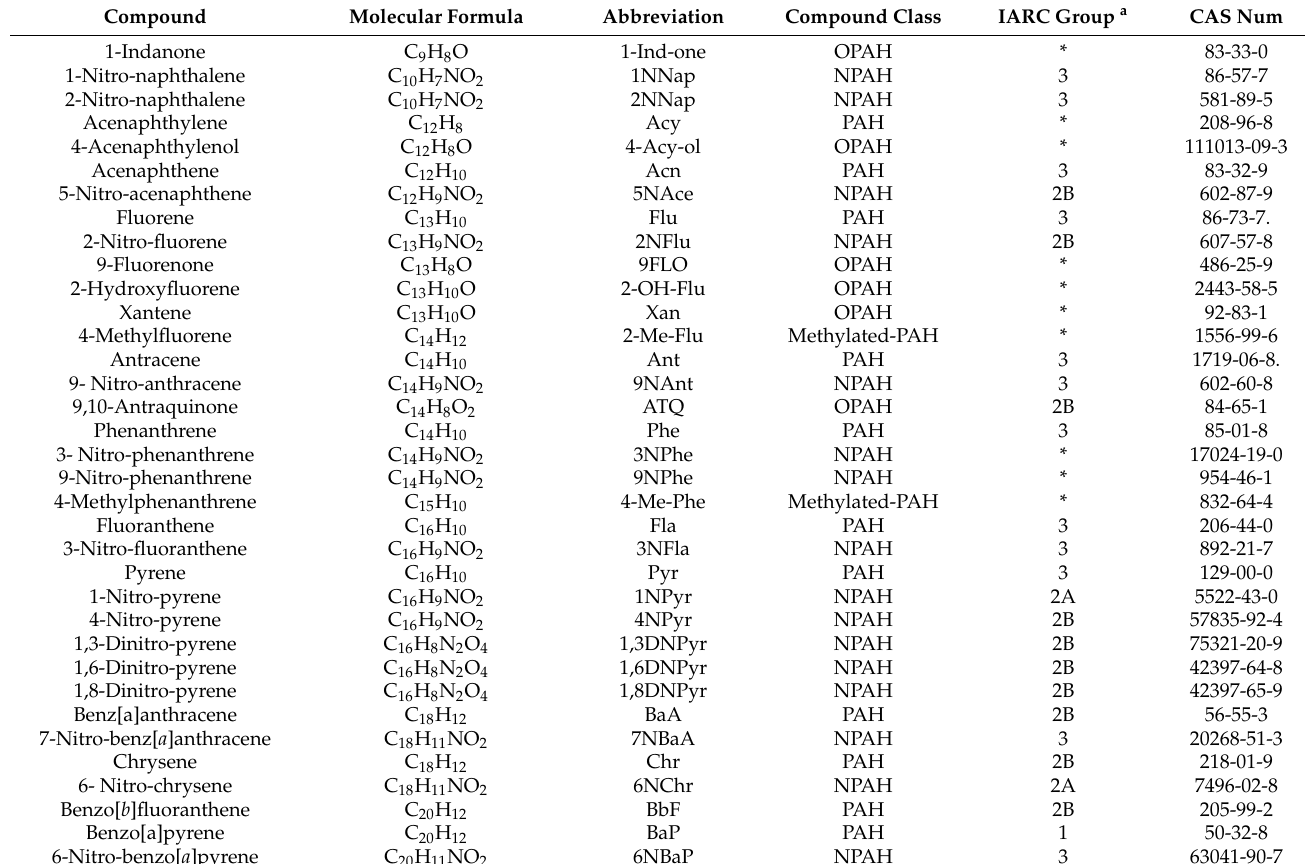
Table 1. List of reported polycyclic aromatic hydrocarbons (PAHs), nitro-PAHs (NPAH) and oxy- PAHs (OPAH) with molecular formula, abbreviations, compound class, carcinogenic classification according to International Agency for Research on Cancer (IARC) and CAS